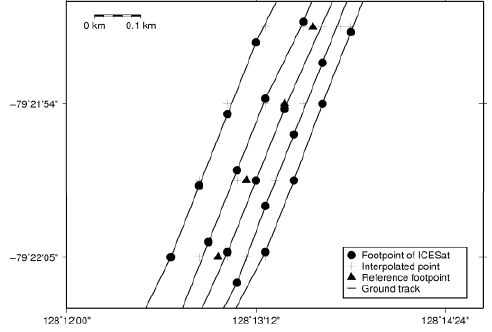
Figure 2. ICESat ground tracks and reference